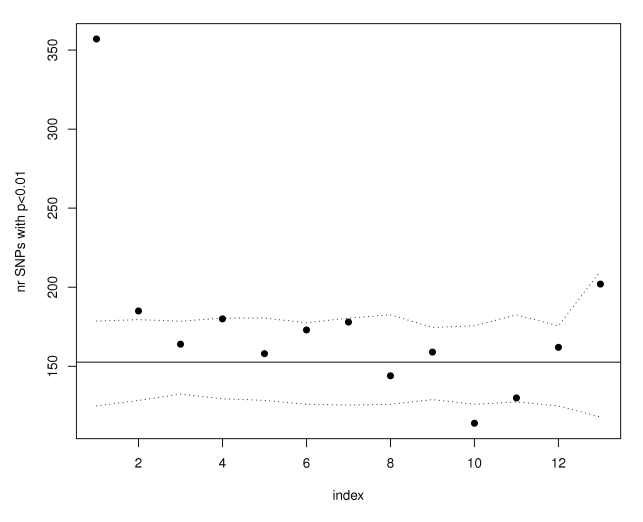
SNPs with the highest eQTL function scores are enriched for WTCCC Crohn's susceptibility loci.SNPs were ordered according to their eQTL function scores from most significant to least significant and divided in groups of 10,000. Only the data from the first 13 groups is shown (as 13 index bins along the X-axis) because fewer than 130K SNPs have expression scores larger than zero. Each point in the graph corresponds to eQTL function score bins and the y-axis shows the number of SNPs in each bin that have WTCCC Crohn's GWAS p-values less than 0.01. The horizontal line illustrates the expectation based on the observed number of SNPs in the whole GWAS that have p-values smaller than 0.01. The proportion of the remaining SNPs with p smaller than 0.01 is 0.014. The dotted lines represent estimated 95% confidence bands obtained using simulations.